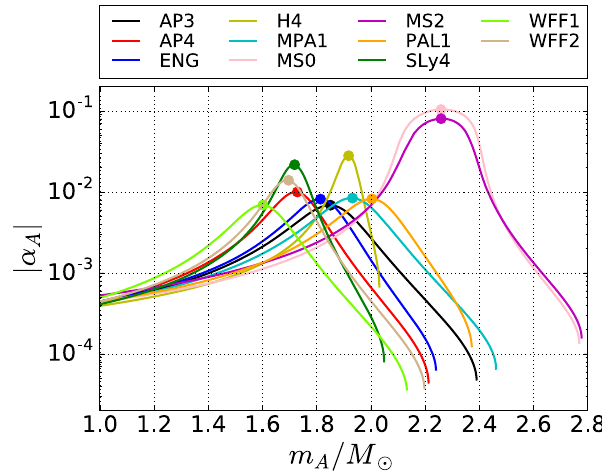
FIG. 5. The effective scalar coupling j α that an isolated NS A j could still develop after taking into account the 95% C.L. constraints from the five pulsars (see Table II). The point of the maximum j α is marked with a dot, and the values (and the A j corresponding masses) are listed in Table